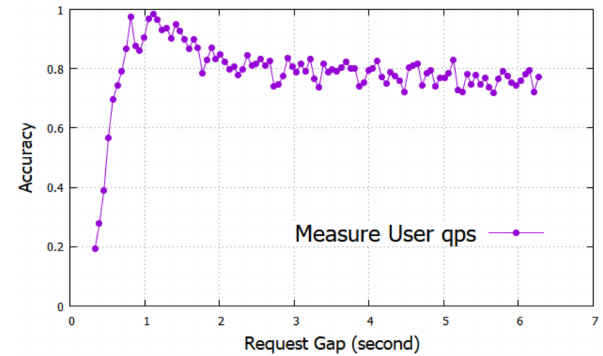
Figure 7. Deviation of the measurement results from the simulation